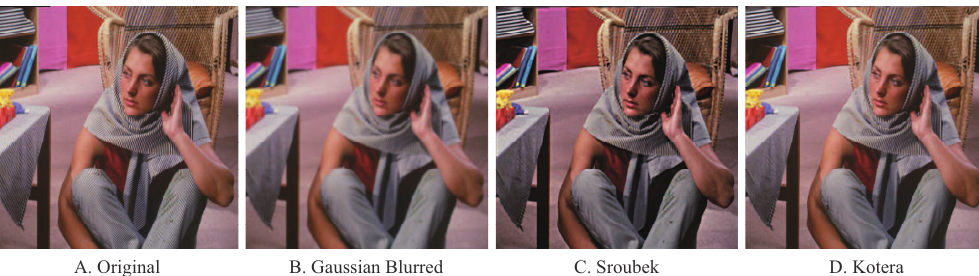
Figure 10. Group 2 restorations: The original image is 512 × 512 × 3 which is provided by IVC dataset while the blurred image is produced by a Gaussian low-pass filter of 11 × 11 with deviation 1.5. The restorations are produced by Sroubek [30] and Kotera [31],